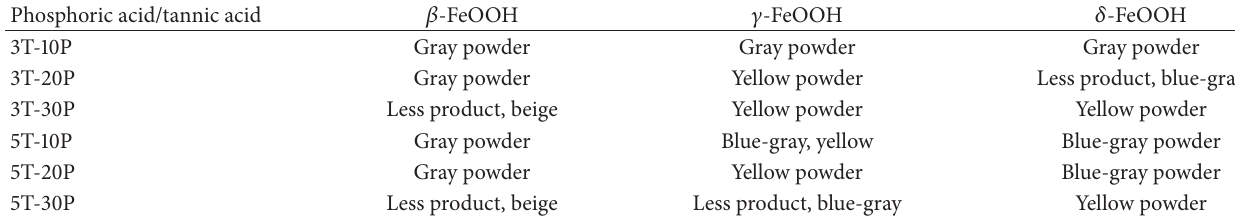
Figure 4: TEM images of different forms of FeOOH. Table 2: The state and color of reaction